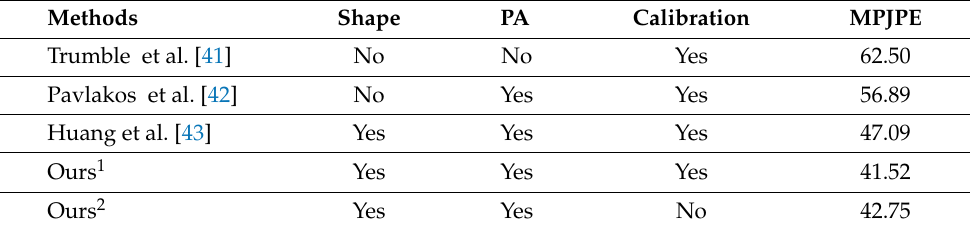
Table 2. Quantitative comparison on Human 3.6M (subject 9). “Shape” indicates if the method estimates the shape parameters. “PA” indicates if Procrustes analysis was applied before computing the MPJPE (mm). Calibration indicates if the ground-truth camera’s extrinsic parameters were used to integrate multi-view data. Ours 1 is the postural reconstruction result with ground-truth extrinsic parameters. Ours 2 shows the results with proposed self-calibration